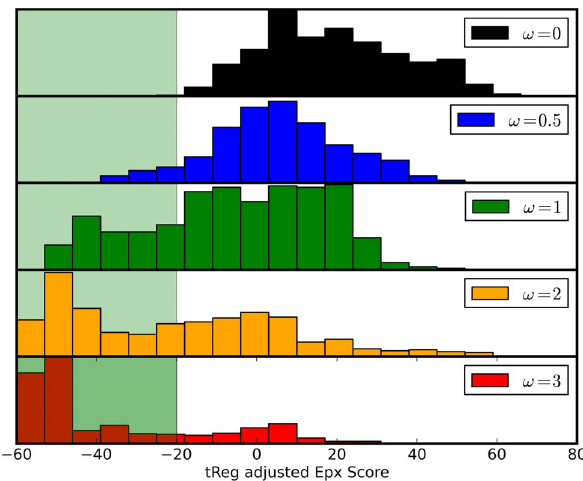
Figure 7. Influence of couplings on generated sequences. The histograms show the distributions of Epivax scores for ensembles of sequences generated with different influence of positional couplings ( v ). The green shaded area marks the desired region for non- immunogenic sequences.